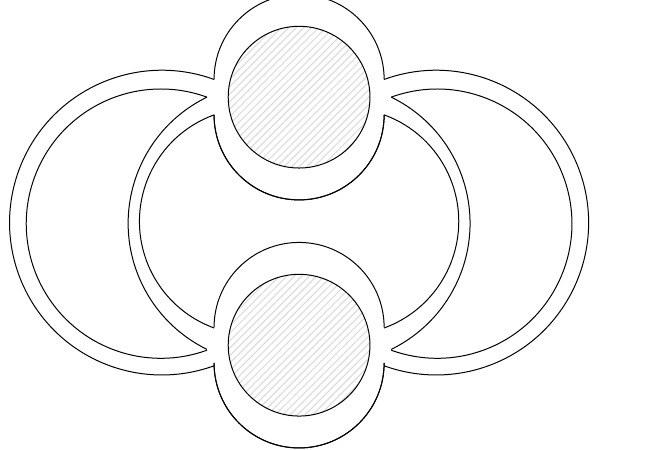
Figure 21. Bubble diagram obtained by joining the corresponding external legs of two copies of the diagram in figure 20.